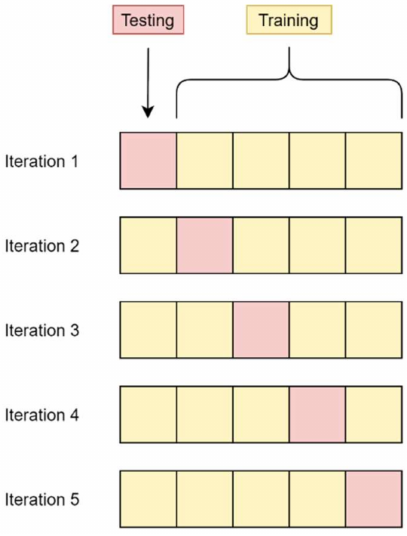
Figure 3. K-fold cross validation process.